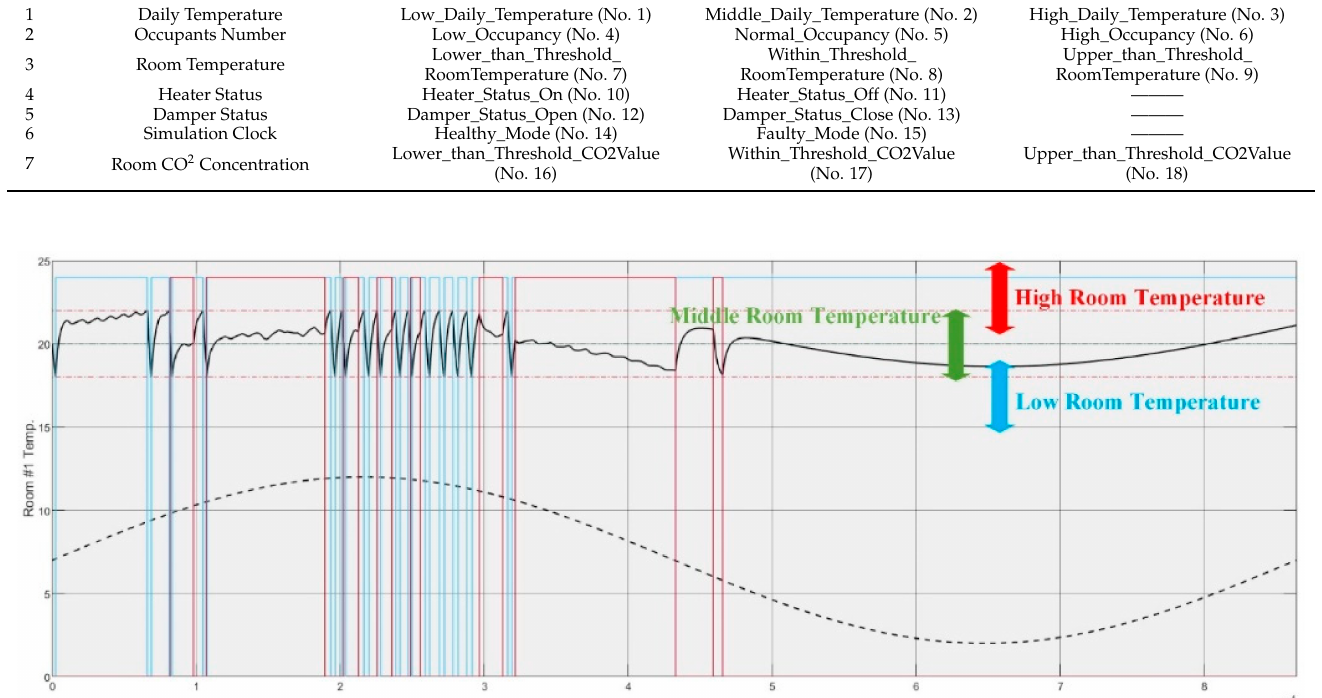
Figure 11. Illustration of subdomains and fuzzy sets definitions for room